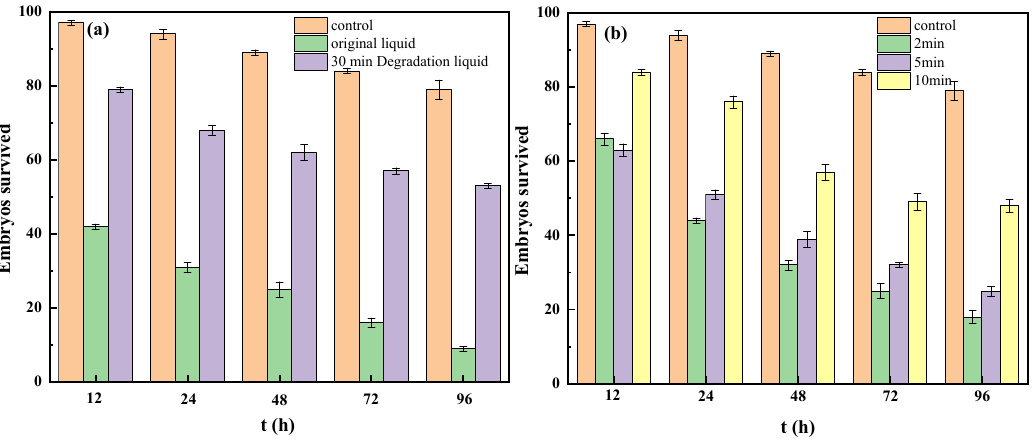
Figure 9. Survival numbers of zebrafish embryos in different solutions ( a ) and reaction time ( b ).